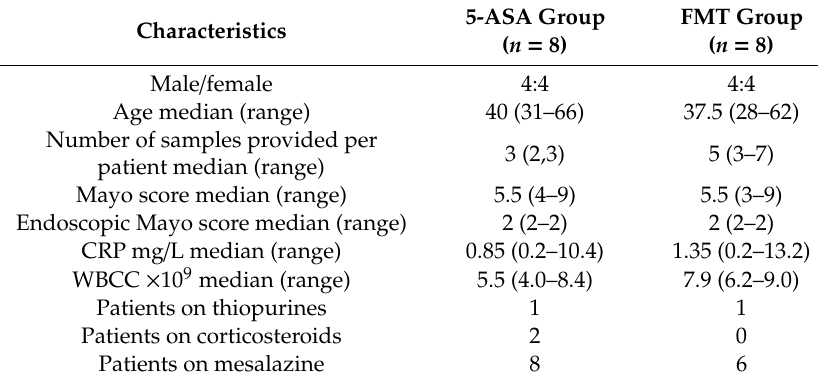
Table 1. Patient study group characteristics before